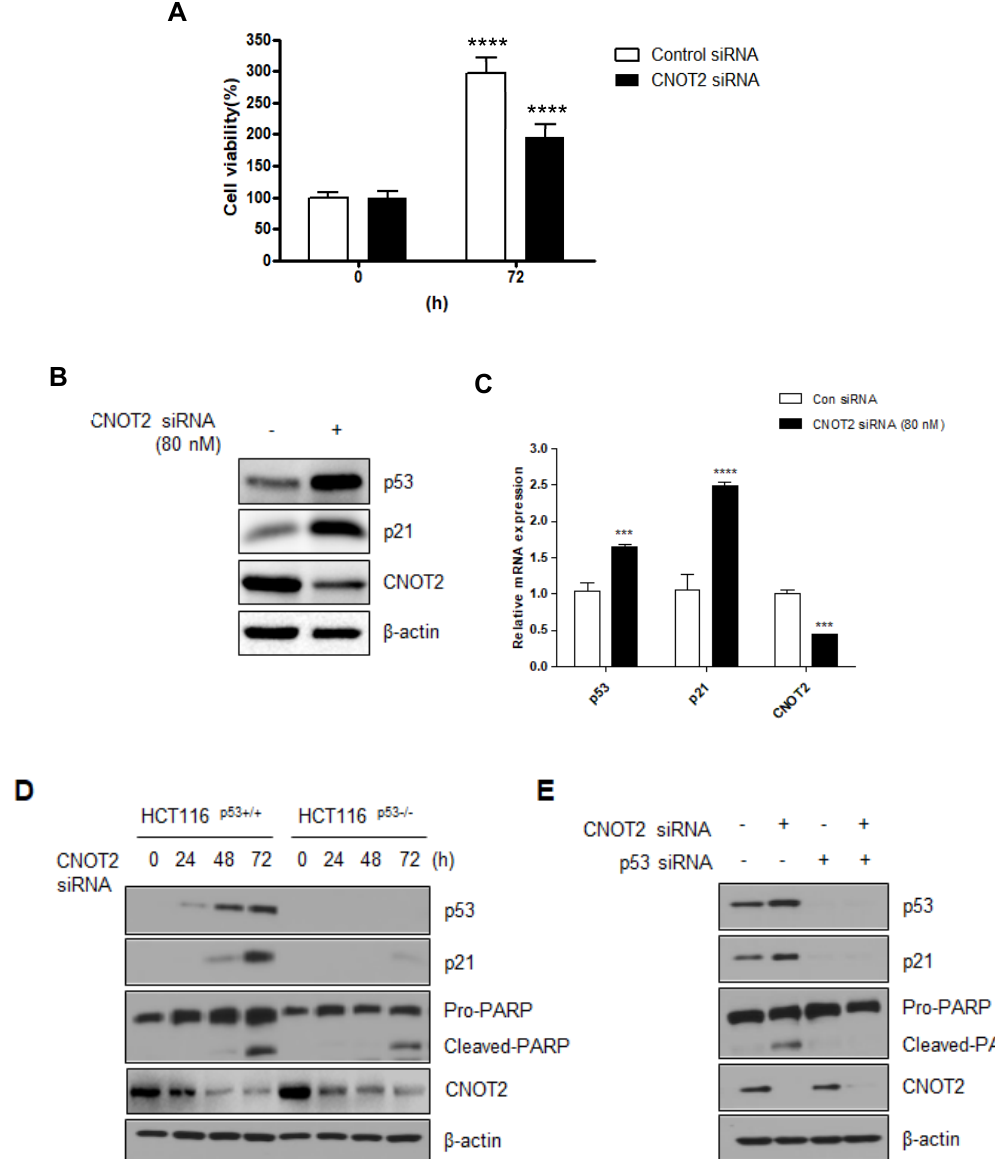
Figure 2. CNOT2 knockdown induces apoptosis by activating p53. ( A ) HCT116 p53+/+ cells were transfected with CNOT2 or scrambled siRNA for 72 h. Cell viability was evaluated by CCK8 assay (Three independent experiments). ( B , C ) HCT116 p53+/+ cells were transfected with CNOT2 or scrambled siRNA for 72 h. After then, cells were harvested for western blotting or qRT-PCR. ( D ) HCT116 p53+/+ and HCT116 p53 − / − cells were transfected with CNOT2 or scramble siRNA at various time points transfection for western blotting with p53, p21, PARP, and β -actin antibodies. ( E ) HCT116 p53+/+ cells were transfected with (Marked as +) CNOT2 siRNA with or without (Marked as -) p53 siRNA after then harvested 72 h post-transfection for western blotting with indicated antibodies. * p value indicates a significant difference between the groups *** p < 0.005, **** p < 0.001.